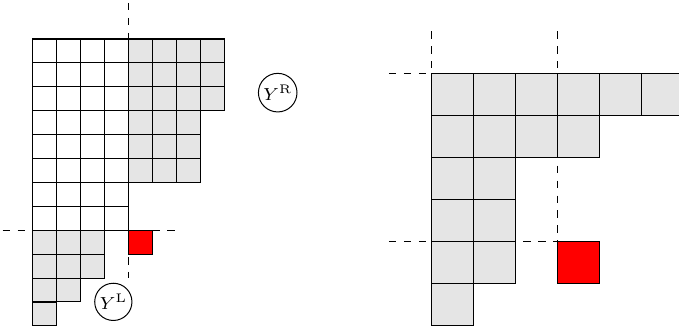
Figure 2 . In the left figure, a large Young diagram Y is depicted with a red “forbidden box”, where we identify the subdiagrams Y L,R as the shaded parts. Apparently, the large diagram contains a n L × n R (width × height)-rectangle of boxes colored in white. On the right, we depict a small Young